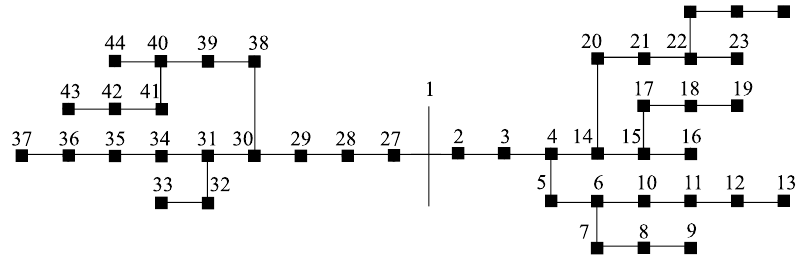
Figure 5. Schematic of a large scale system conformed by 44 buses